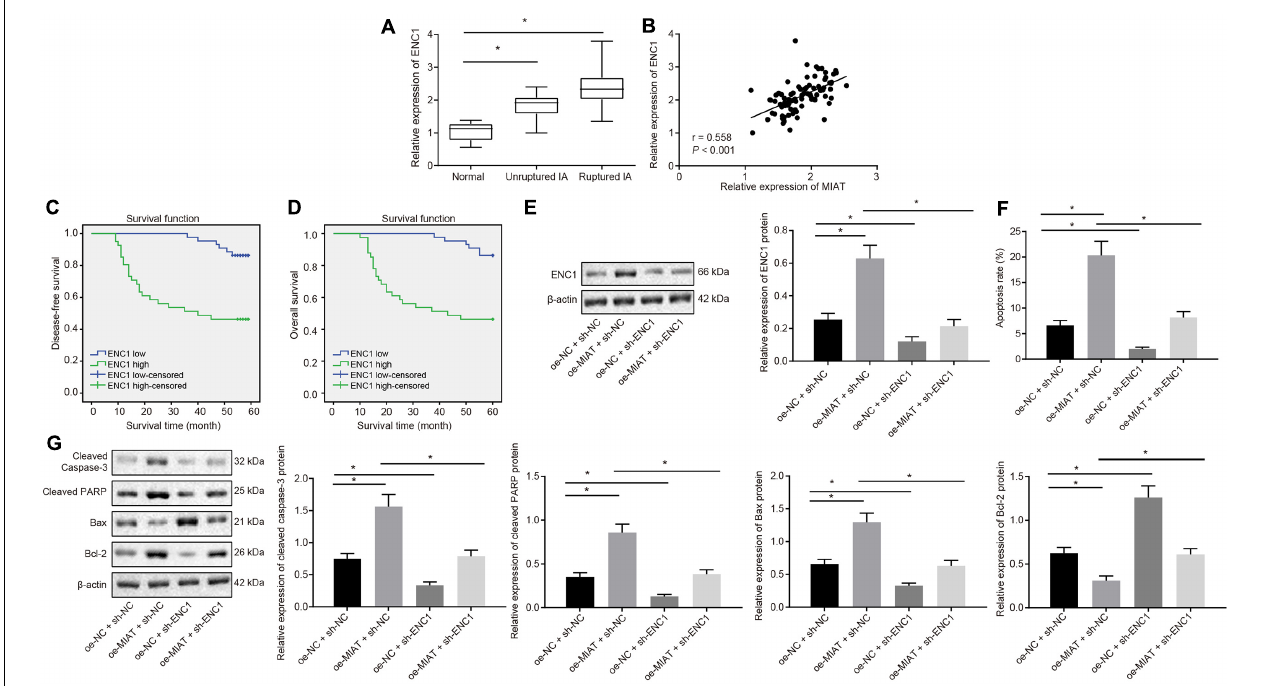
FIGURE 4 | ENC1 expression is augmented in IA patients, and ENC1 silencing negates MIAT-induced endothelial cell apoptosis. (A) ENC1 expression in ruptured IA, unruptured IA and control samples determined by RT-qPCR. (B) Analysis of the correlation between ENC1 expression and MIAT expression. (C) The correlation between the expression of ENC1 and disease-free survival of patients with IA. (D) The correlation between the expression of ENC1 and overall survival of patients with IA. (E) The protein expression of ENC1 in vascular endothelial cells in vitro in response to oe-MIAT and sh-ENC1 alone or in combination measured by Western blot analysis. (F) Flow cytometry analysis for apoptosis of endothelial cells in response to oe-MIAT and sh-ENC1 alone or in combination. (G) The expression of apoptosis-related factors (cleaved Caspase-3, cleaved PARP1, Bax, and Bcl-2) in response to oe-MIAT and sh-ENC1 alone or in combination measured by Western blot analysis. * p < 0.05. The measurement data were expressed as mean ± standard derivation. Comparisons between two groups were analyzed by unpaired t test, while the correlation between the expression of ENC1 in patients with IA and their disease-free survival and overall survival was analyzed by Kaplan–Meier method (long-rank test). Comparisons among multiple groups were analyzed by one-way ANOVA followed by Tukey’s post hoc test, and the cell experiment was conducted three times